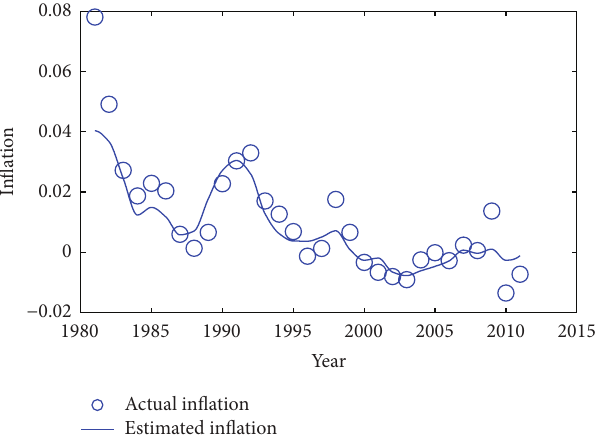
Figure 3: The actual inflation versus estimated inflation.